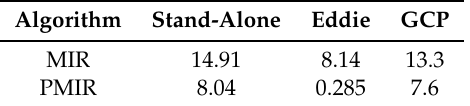
Table 3. Processing time (in seconds) of MIR and PMIR on stand-alone, Eddie, and GCP. Algorithm